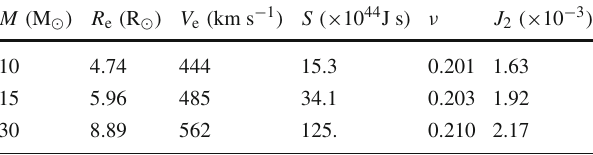
Table 2 ESTER models for Zero-Age Main Sequence (ZAMS) stars with an equatorial angular velocity at 70% of the critical angular veloc- ity. R e and V e are the equatorial radius and velocity, respectively, S is the total spin angular momentum, ν is the flattening, and J 2 is the dimensionless mass quadrupole moment. The metallicity is Z=0.02 and the hydrogen mass fraction is X = 0 . 7. In our simulations, we use the parameters of the star with 15M (cid:2) listed here M ( M (cid:2) ) R e ( R (cid:2) ) V e ( km s − 1 ) S ( × 10 44 J s )